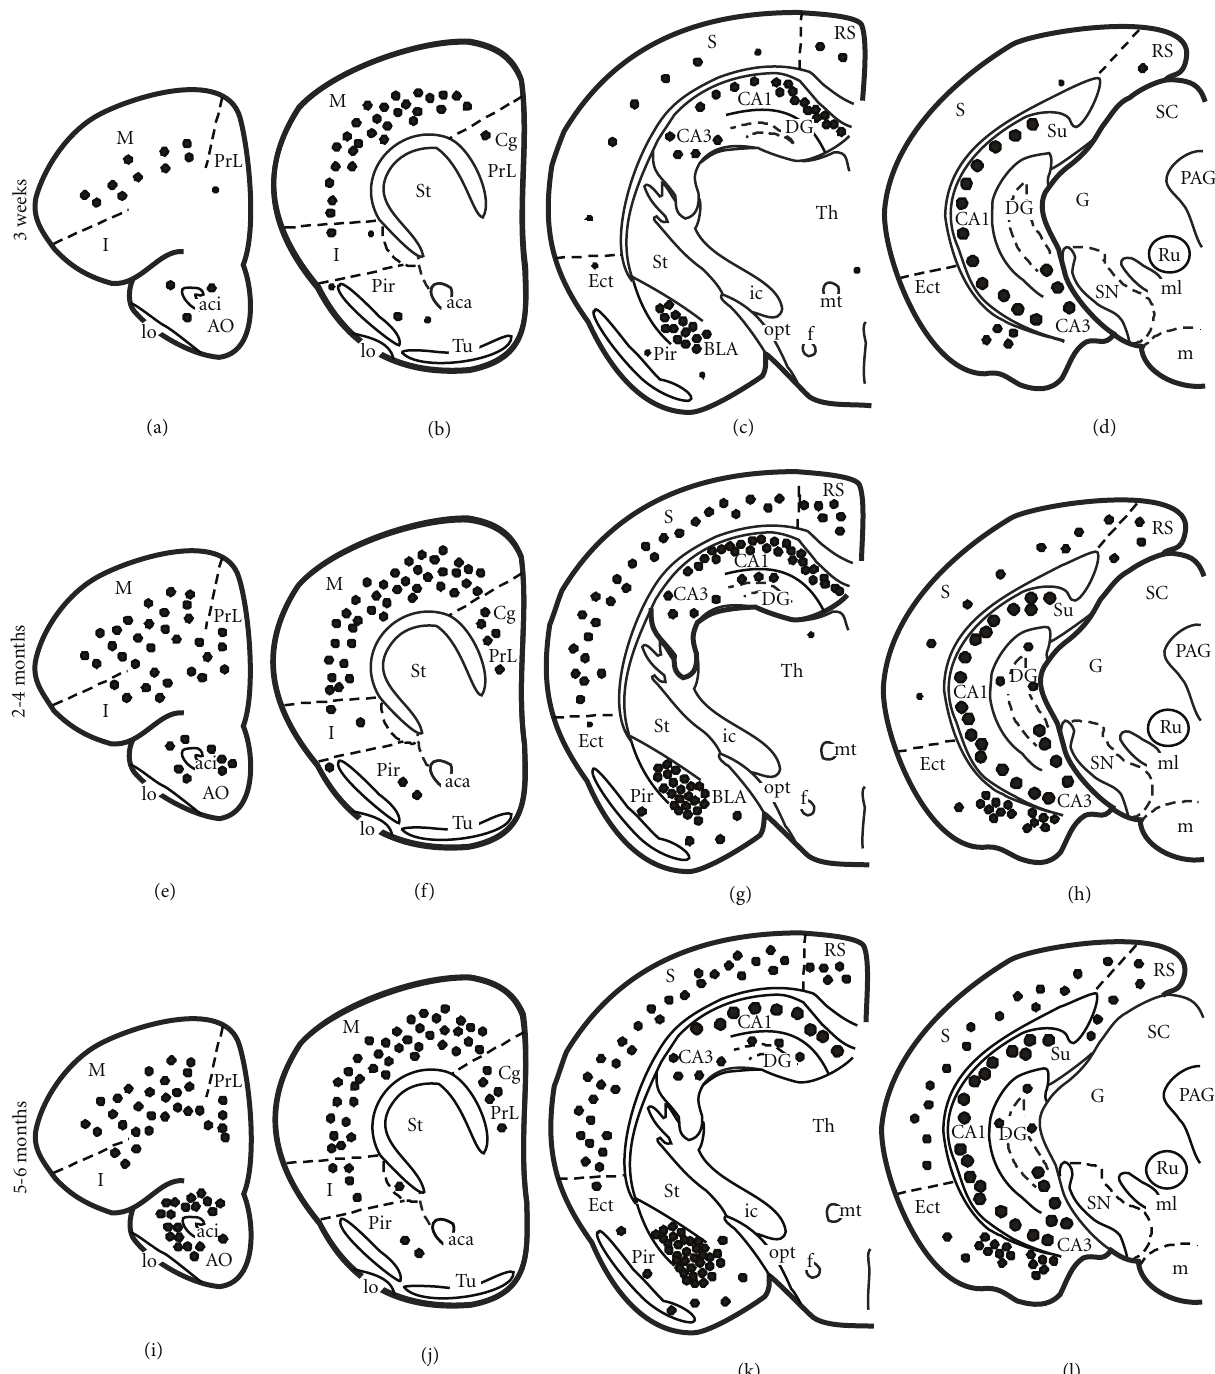
Figure 2: Schematic drawings representing the distribution of 6E10-ir neurons in 3-week, 2-, and 5-month-old perfusion-fixed 3xTg- AD transgenic mice. Note the age-related increase in the number of 6E10 positive neurons in the cortex, hippocampus, and